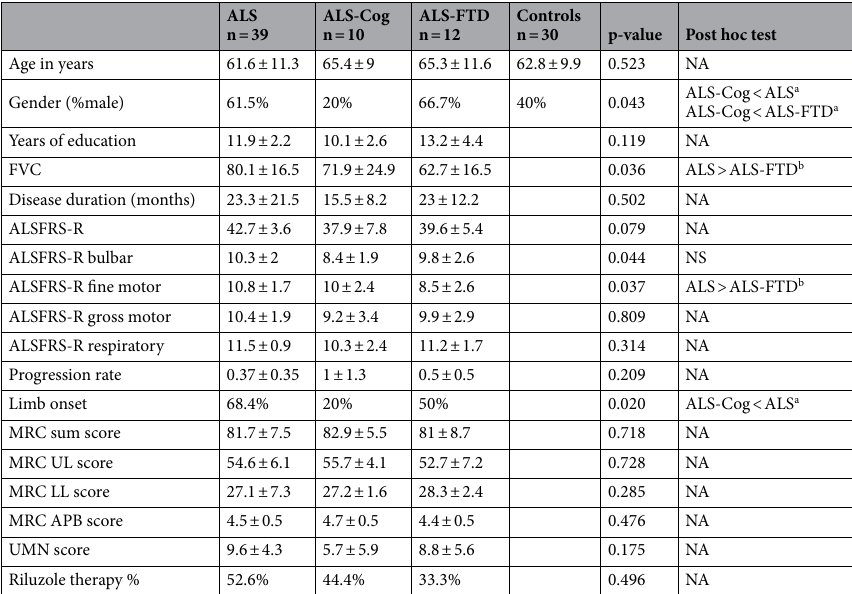
higher in ALS-Cog (80%) compared with ALS (p = 0.01). While overall level of motor function measured using the ALSFRS-R score was similar between the groups, there was more impairment in fine motor component of ALSFRS-R in ALS-FTD (8.5 ± 2.6) when compared to ALS (10.8 ± 1.7, p = 0.006). Duration of disease symptoms was not significantly different between the three patient groups. Cognitive and behavioural function. Total ACE score was below the normal cut off (< 88) 34 in both ALS-Cog (82.3 ± 10.2) and ALS-FTD (74.5 ± 8.6) groups. Total MiND-B 36 scores also showed impairment in ALS-Cog and ALS-FTD patients. There were significant group differences in all measures of cognition tested, as shown in Table 2. Likewise, behavioural scores on MiND-B and subdomain scores were significantly different between ALS, ALS-Cog and ALS-FTD (p < 0.001 for all measures). On post hoc testing, the results for the ALS- Cog group were intermediate between ALS-Cog and pure motor ALS (Table 2). Motor cortical function characteristics. Motor cortical function measures on TMS are summarised in Table 3. Average RMT was lower in ALS-FTD (50.2 ± 6.9) compared with healthy controls (64.3 ± 12.6, p = 0.009). In ALS-Cog and ALS, RMT was similar to control values (Table 3, Fig. 1). Average SICI was lower in all three groups, ALS (5.1 ± 9.2), ALS-Cog (− 1.5 ± 7.8) and ALS-FTD (3.1 ± 8.6) compared with healthy controls (11.3 ± 6, p < 0.001 for group comparisons). Peak SICI was lower in ALS-Cog (8.4 ± 7.6) compared with control values (19.2 ± 8.8, p = 0.019). ICF, CSP and MEP amplitude were similar to control values in all 3 patient groups.